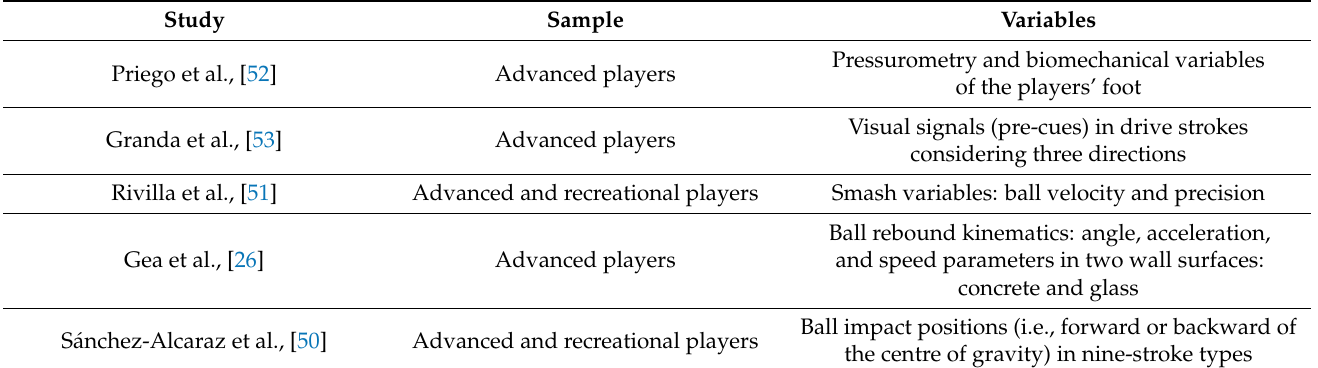
Table 2. Summary of studies exploring biomechanics in